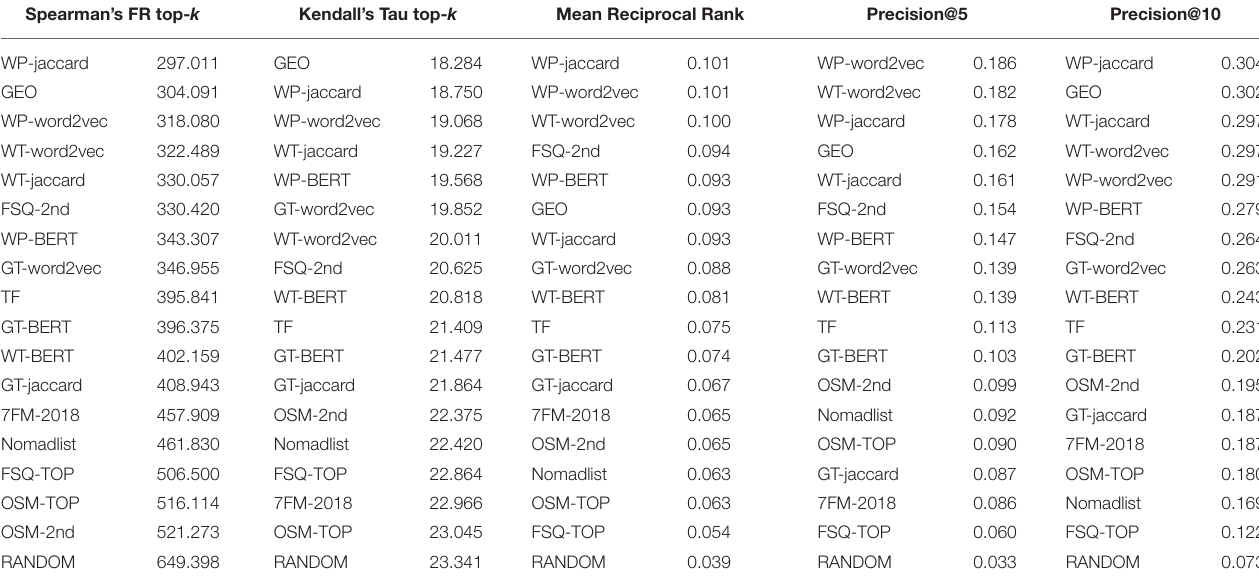
TABLE 4 | Ranking of the different data sources using the modified rank agreement methods for top- k lists as well as MRR and Precision. Spearman’s FR top- k Kendall’s Tau top- k